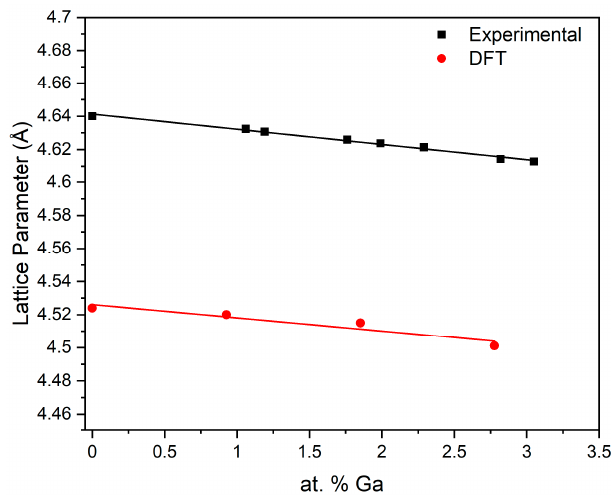
Figure 2. Experimental and density functional theory (DFT) calculated lattice parameters as a function of Ga dependency. Experimental data is from Ellinger et al. [3].